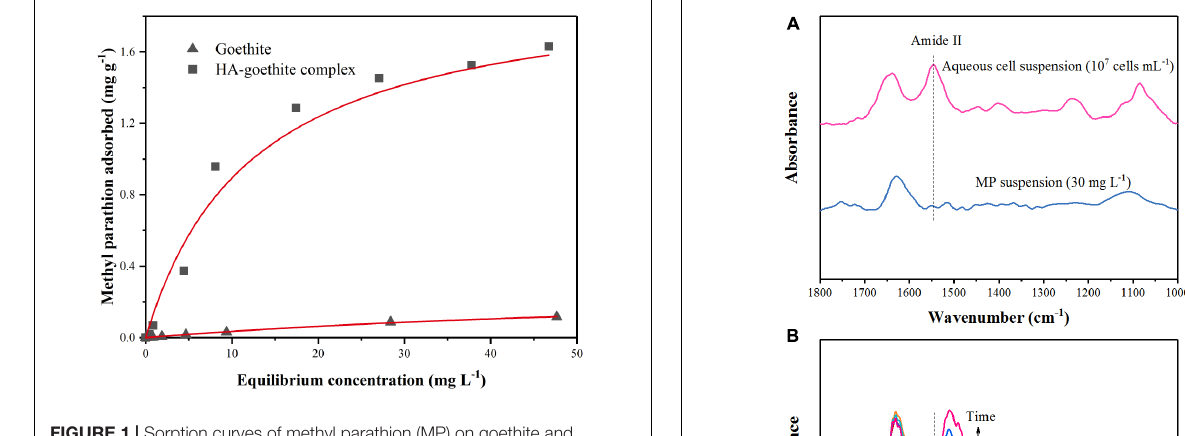
FIGURE 1 | Sorption curves of methyl parathion (MP) on goethite and HA-goethite complex.